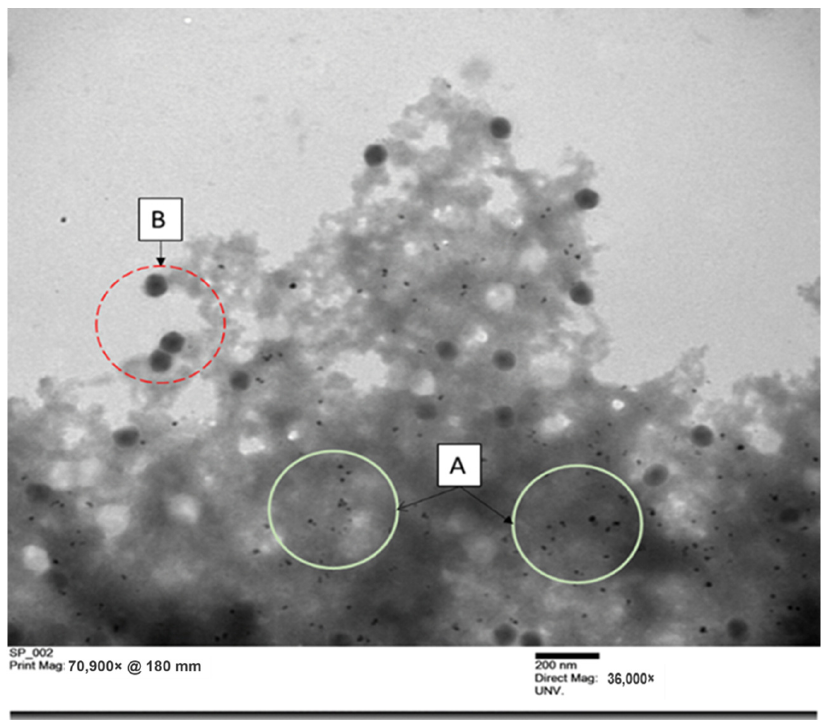
Figure 6. Distribution of phage particles and silver nanoparticles in alginate matrix observed using transmission electronic microscope: (A) AgNP particles, (B) phage particles.